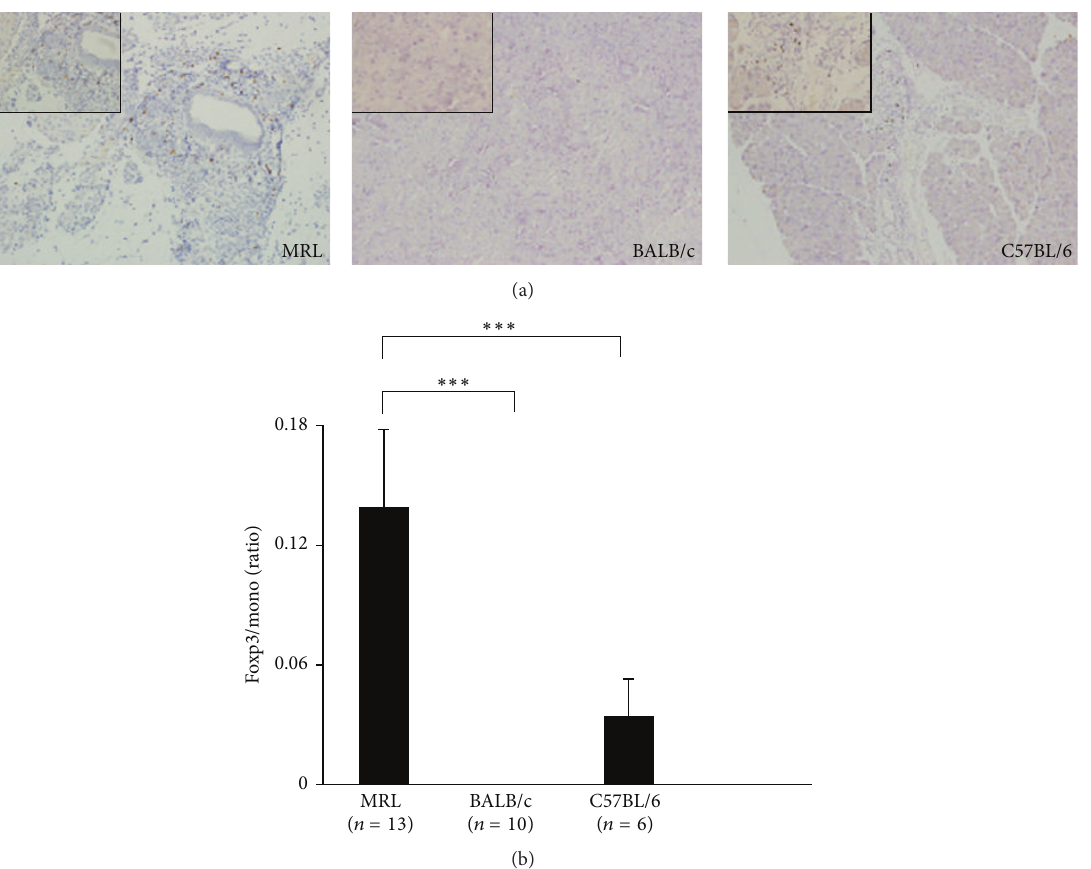
Figure 5: Representative immunostaining of Foxp3 in the pancreases (a) and the ratios of Foxp3/mono (Foxp3-positive cells/infiltrated mononuclear cells) in the pancreases (b) of poly I:C-treated MRL/Mp mice at the age of 18–20 weeks, poly I:C-treated BALB/c mice at the age of 18 weeks, and poly I:C-treated C57BL/6 mice at the age of 18 weeks. In MRL/Mp and C57BL/6 mice, abundant infiltration of Foxp3- positive cells was found among the lymphoid infiltrates in the pancreas but not in BALB/c mice. The Foxp3/mono ratios in MRL/Mp mice were significantly increased compared with BALB/c and C57BL/6 mice. × 100 magnification (large panel), × 400(inset). Data are expressed as mean ± SEM; ∗∗∗ 𝑃 < 0.001